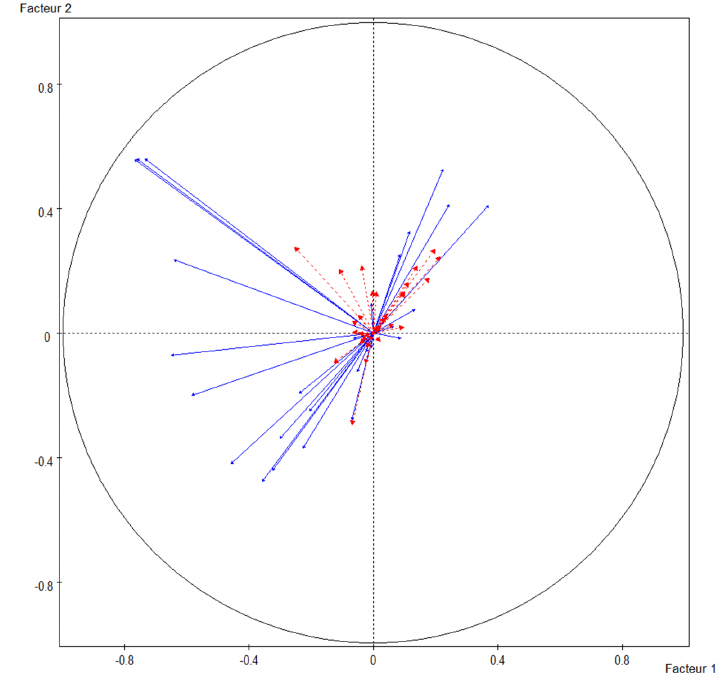
Land 2023 , 12 , x FOR PEER REVIEW Figure 3. Biplot of PCA in the northeastern district. Figure 3. Biplot of PCA in the northeastern district.